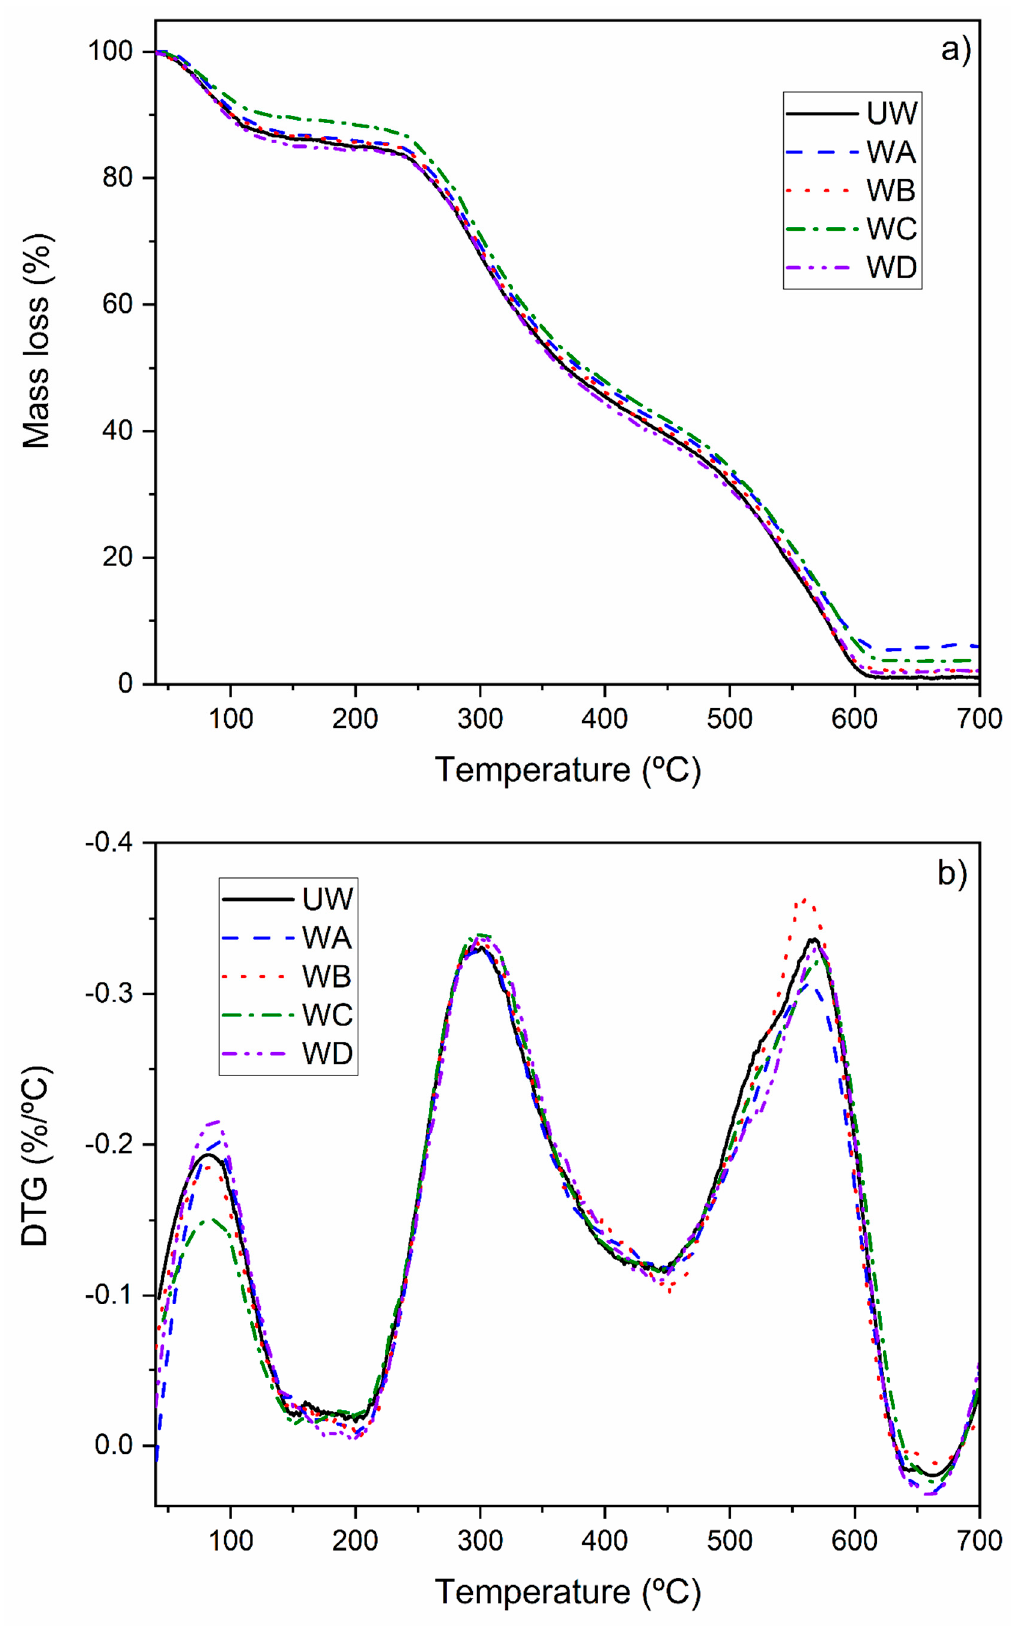
Figure 4. ( a ) Thermogravimetric analysis (TGA) and ( b ) first derivative of the TGA curve (DTG) of unmodified wool (UW) and wool modified with studied coupling agents (WA, WB, WC, WD).